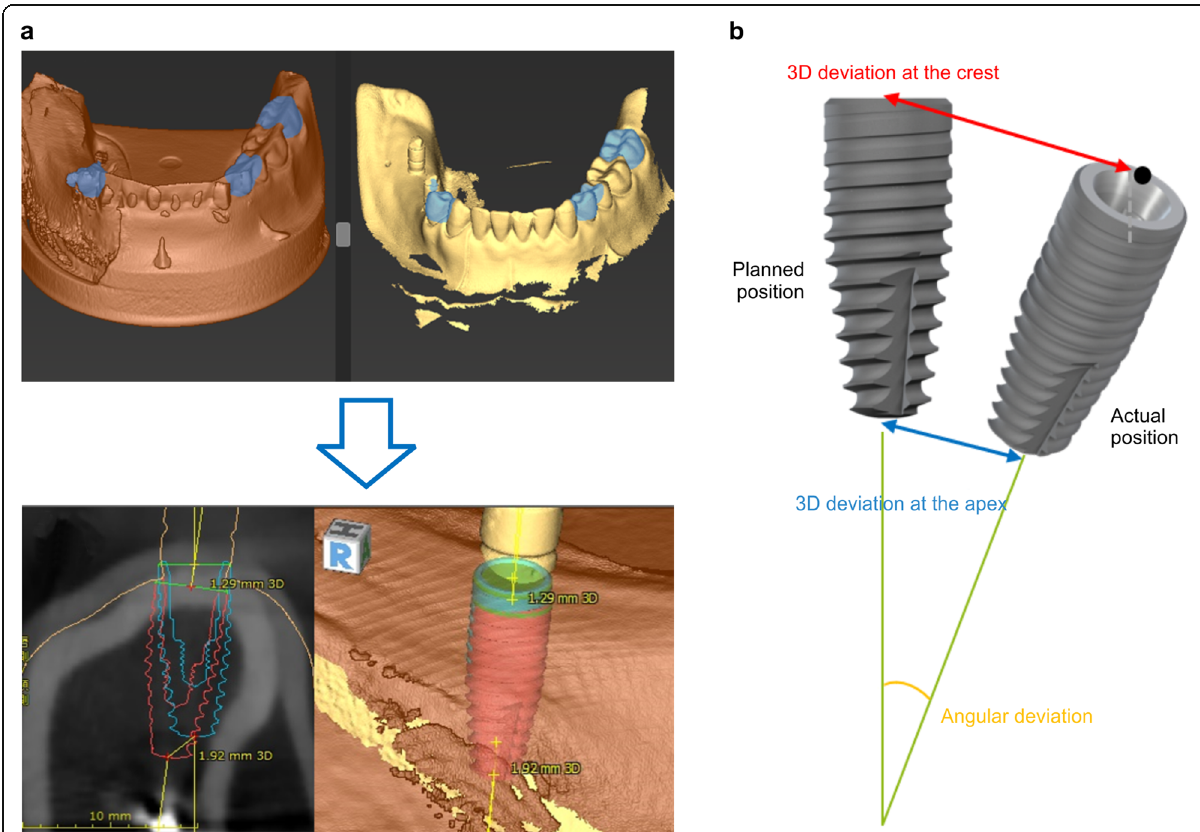
Fig. 4 Measurement of errors. a After implantation, STL data of the resin model equipped with a scan body are superimposed on coDiagnostiX simulation data. Accuracy was measured using the treatment evaluation tool. Blue: implantation position set using simulation. Red: